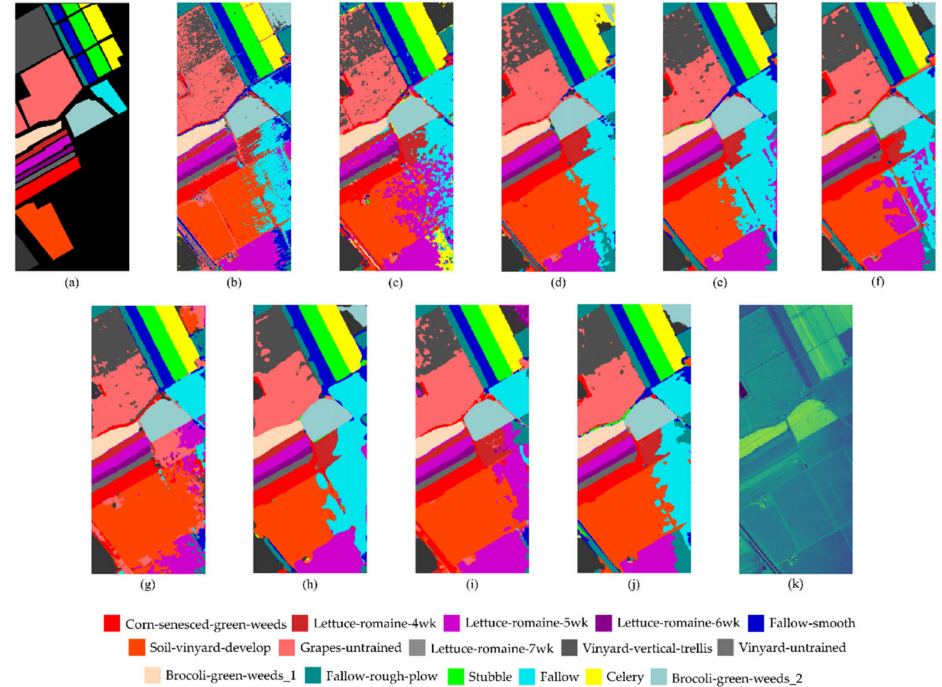
Figure 11. Full-factor classification maps for the SA dataset. ( a ) Ground-truth. ( b ) SVM. ( c )